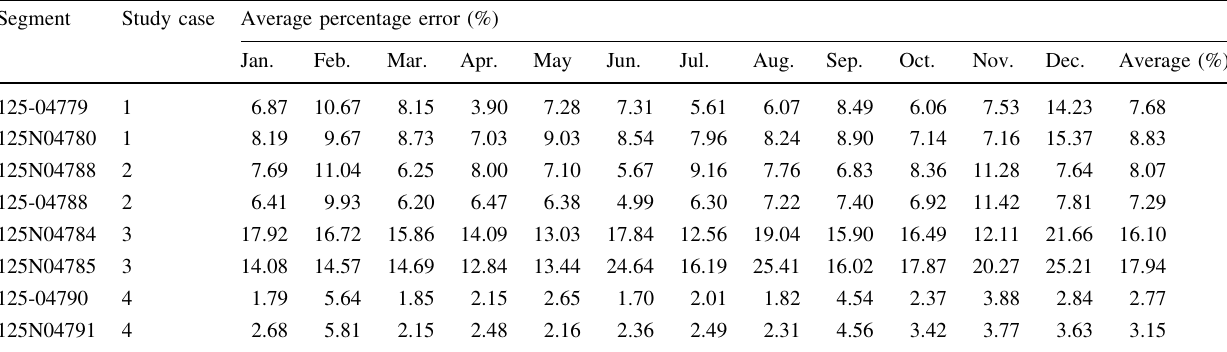
Table 8 Percentage prediction errors (January to December) Segment Study